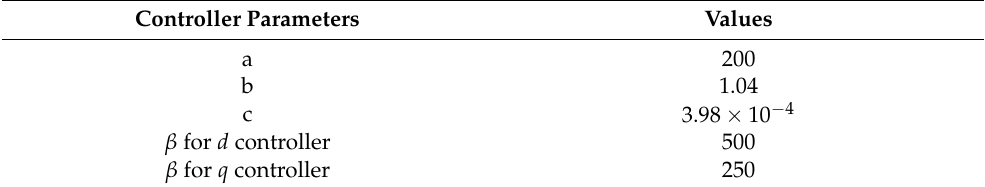
Table 4. Controller parameters of the VSI.